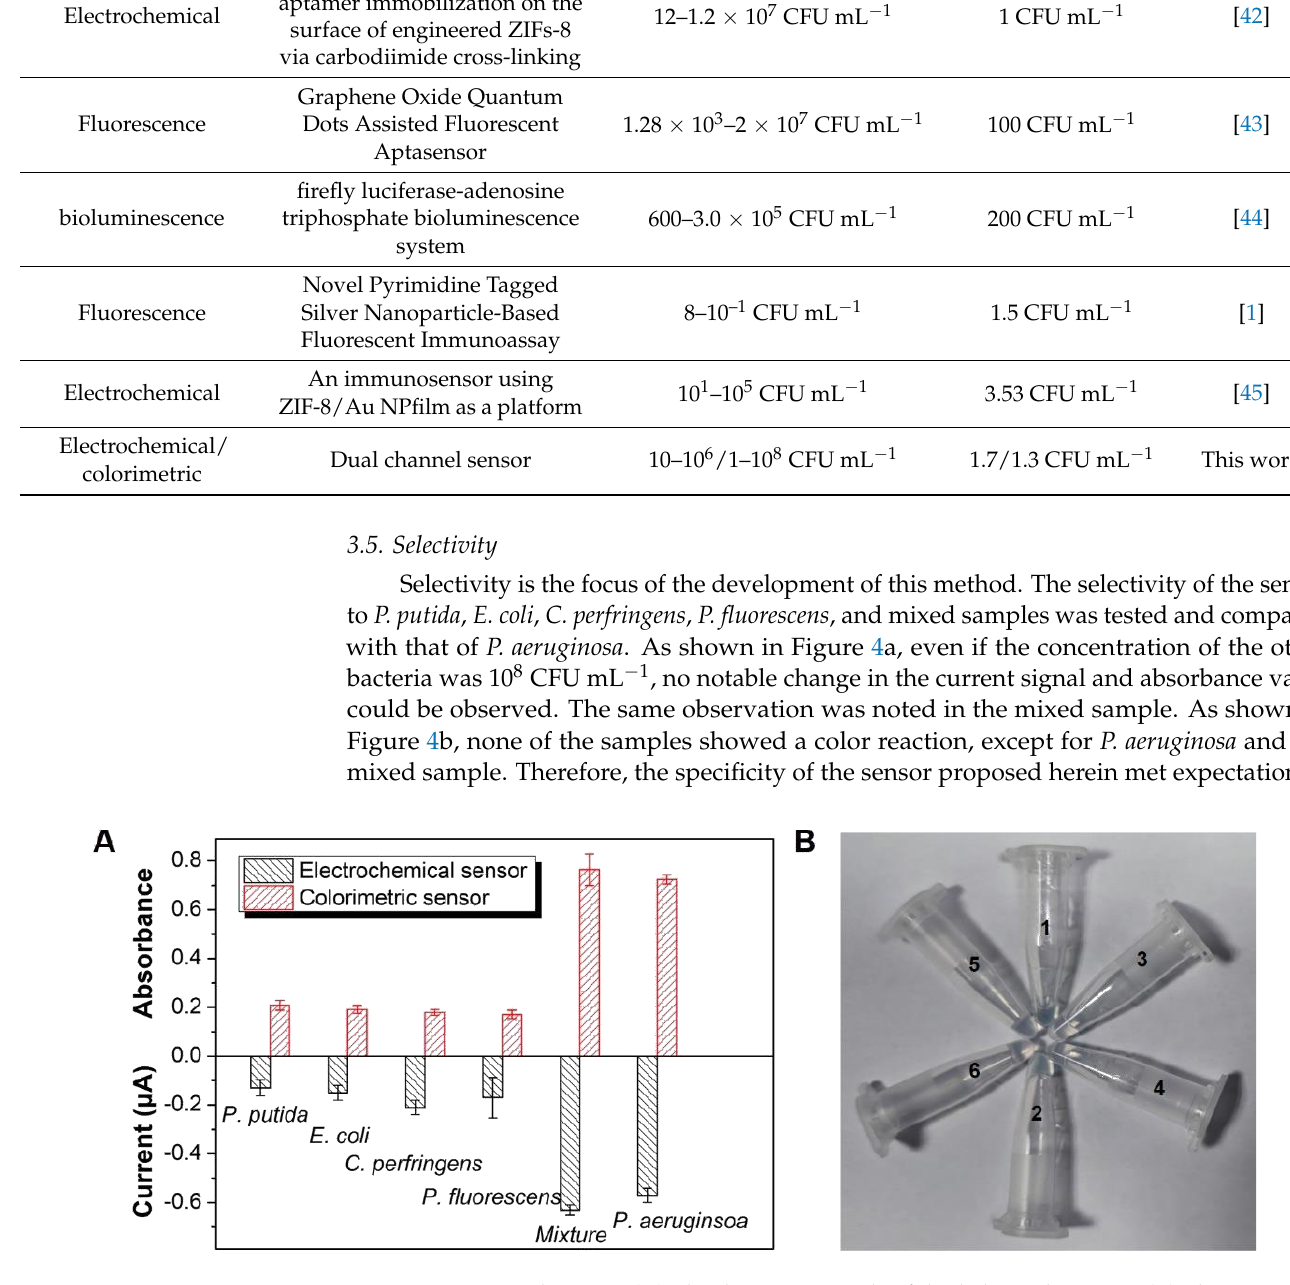
Figure 4. Sensor selectivity. ( A ) The detecting signals of dual-channel sensors. ( B ) Photograph of reaction solution for colorimetric sensing. From 1 to 5: P. aeruginosa , mixture, P. putida , E. coli and C. perfringens , P. fluorescens . P. aeruginosa : 10 2 CFU mL − 1 , others: 10 8 CFU mL − 1 , 10 2 CFU mL − 1 P. aeruginosa , and others 10 8 CFU mL − 1 used as mixture. The photo was collected after 8 min of reaction.